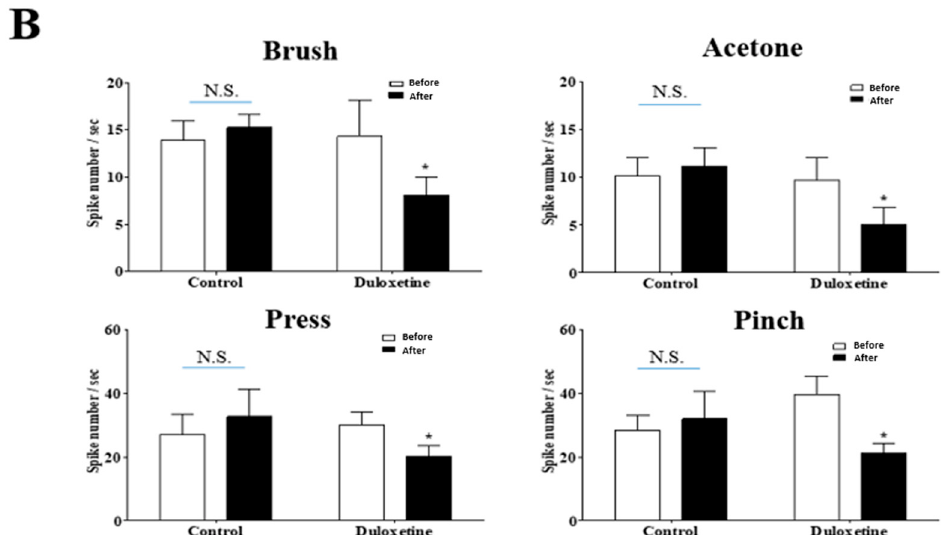
Figure 2. Duloxetine decrease the hyperexcitability of spinal wide dynamic range (WDR) cells induced by oxaliplatin. Representative extracellular recording raw traces of WDR neuron responses to press stimulation before and one hour after the intraperitoneal injection of 30 mg/kg of duloxetine ( A ). Frequency of neuronal activity to brush, press, pinch and cold stimulations were measured before and one hour after the administration of duloxetine (30 mg/kg, i.p., n = 6–7) ( B ). The same volume of D.W.